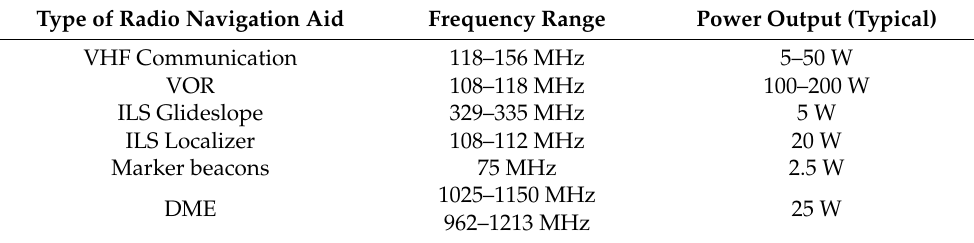
Table 1. The frequency and power of emissions of ground-based radio navigation equipment. Type of Radio Navigation